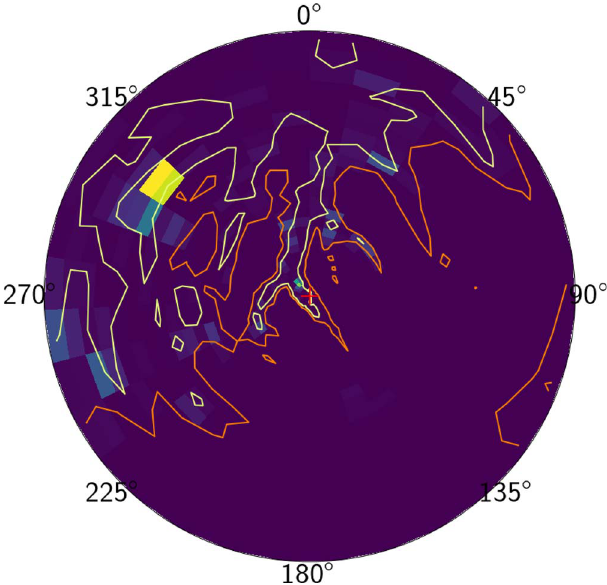
Fig. A.1. Ground map used for the model in a 100 km radius around the instrument (red cross). The emissions are shown in yellow (we can note the small patch of Skibotn just North – West from the instrument and the larger area covered by Tromsø further away). Superposed are the lines of constant altitudes at 200 m (yellow) and 500 m (orange) above sea level. These are the altitudes used for the albedo de fi nition.